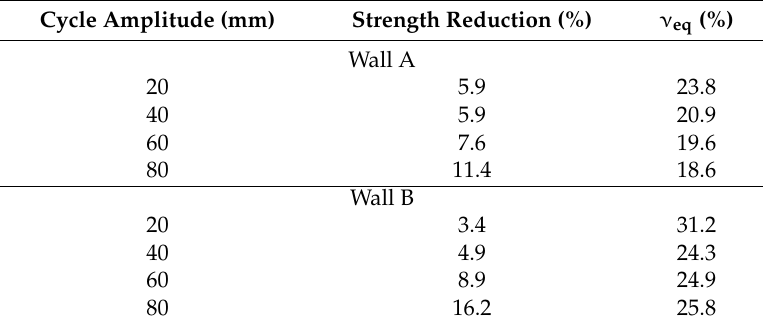
Table 3. Strength degradations and equivalent viscous damping at each cycle